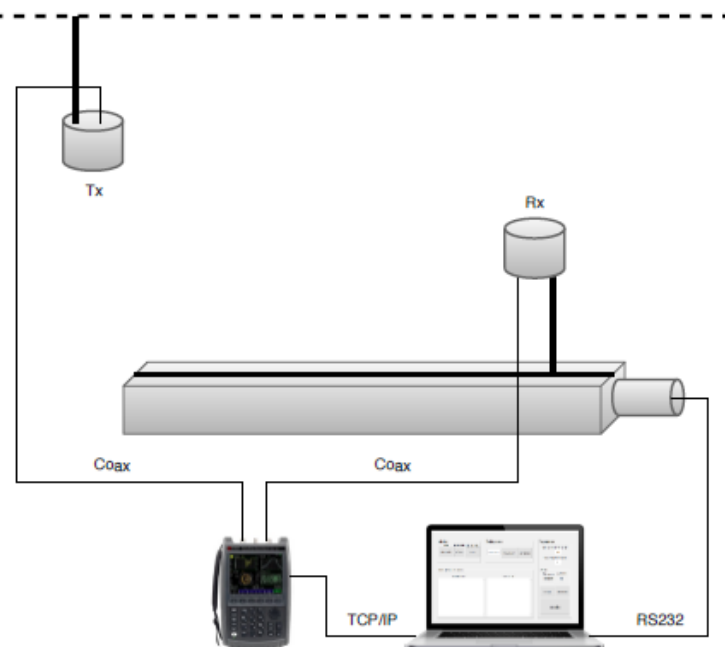
Figure 1. Scheme of the measurement setup.